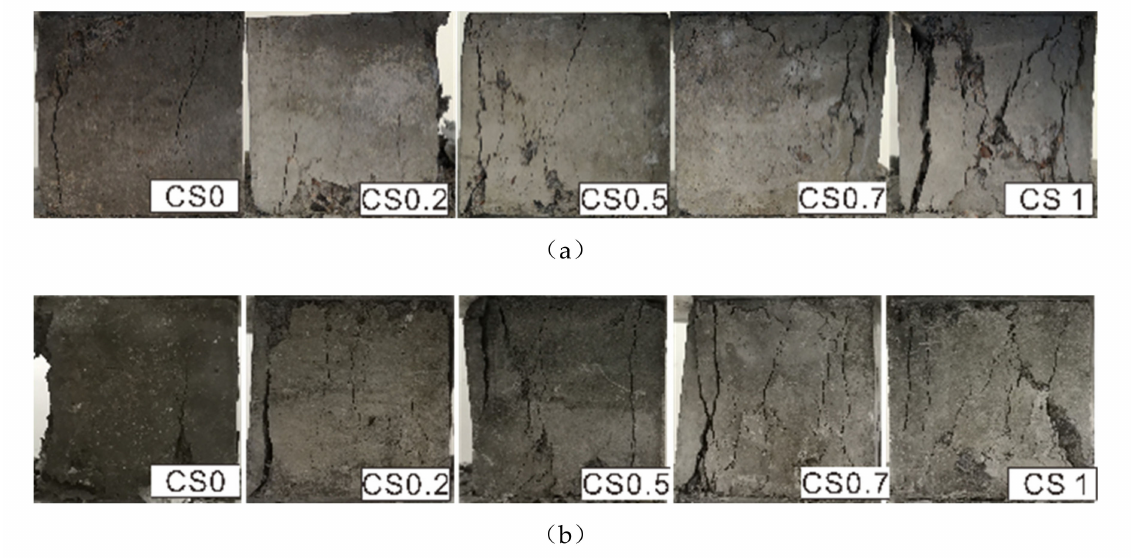
Figure 5. Appearance of compressive strength damage: eroded 180 d ( a ) and 360 d ( b ). It was clear from these analytical results that changes the compressive strength mainly depended on the cement hydration, SO 42 − concentration in the salt solution, and attack time. Long-term attack led to changes in the concrete structure to a certain depth. As SO 42 − and Cl − reacted with hydration products in concrete, they changed the